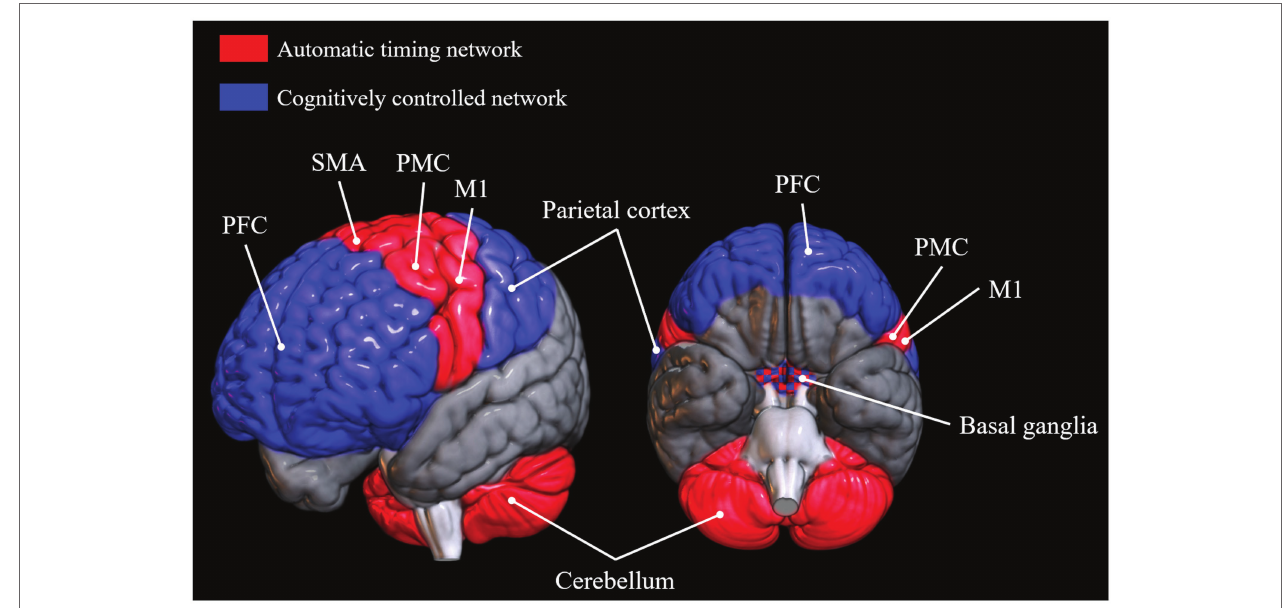
FIGURE 1 | Brain areas reported to be active in tasks requiring automatic timing and cognitively controlled timing, respectively (Lewis and Miall, 2003; Buhusi and Meck, 2005; Koch et al., 2009; Coull et al., 2011, 2013; Repp and Su, 2013). Brain networks were plotted onto a standard MNI152 template rendered with the open-source software MRIcroGL (McCausland Center for Brain Imaging, University of South Carolina). PFC, prefrontal cortex; SMA, supplementary motor area; PMC, premotor cortex; M1, primary motor